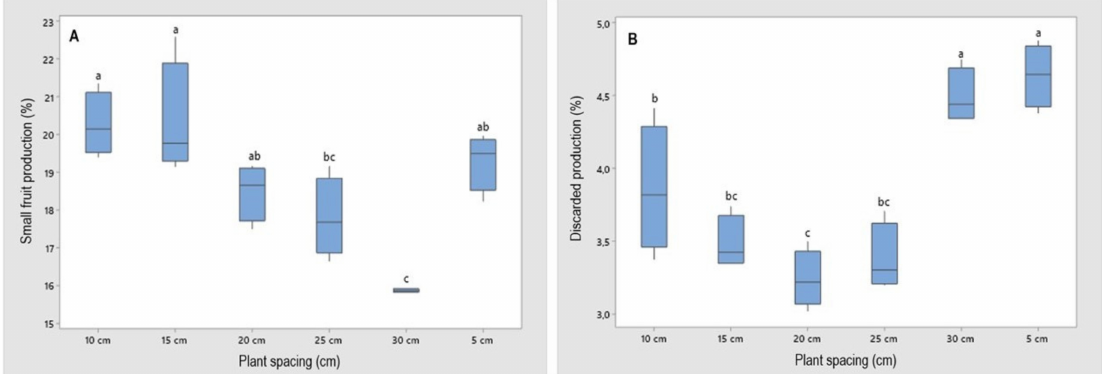
Figure 4. The percentage of small fruit ( A ) and fruit classified as discard ( B ) of strawberry cv. ‘Pircinque’ depending on the different spacing between plants with average of the 2018/2019 and 2019/2020 harvests. For each spacing, the different letters indicate significant differences ( p ≤